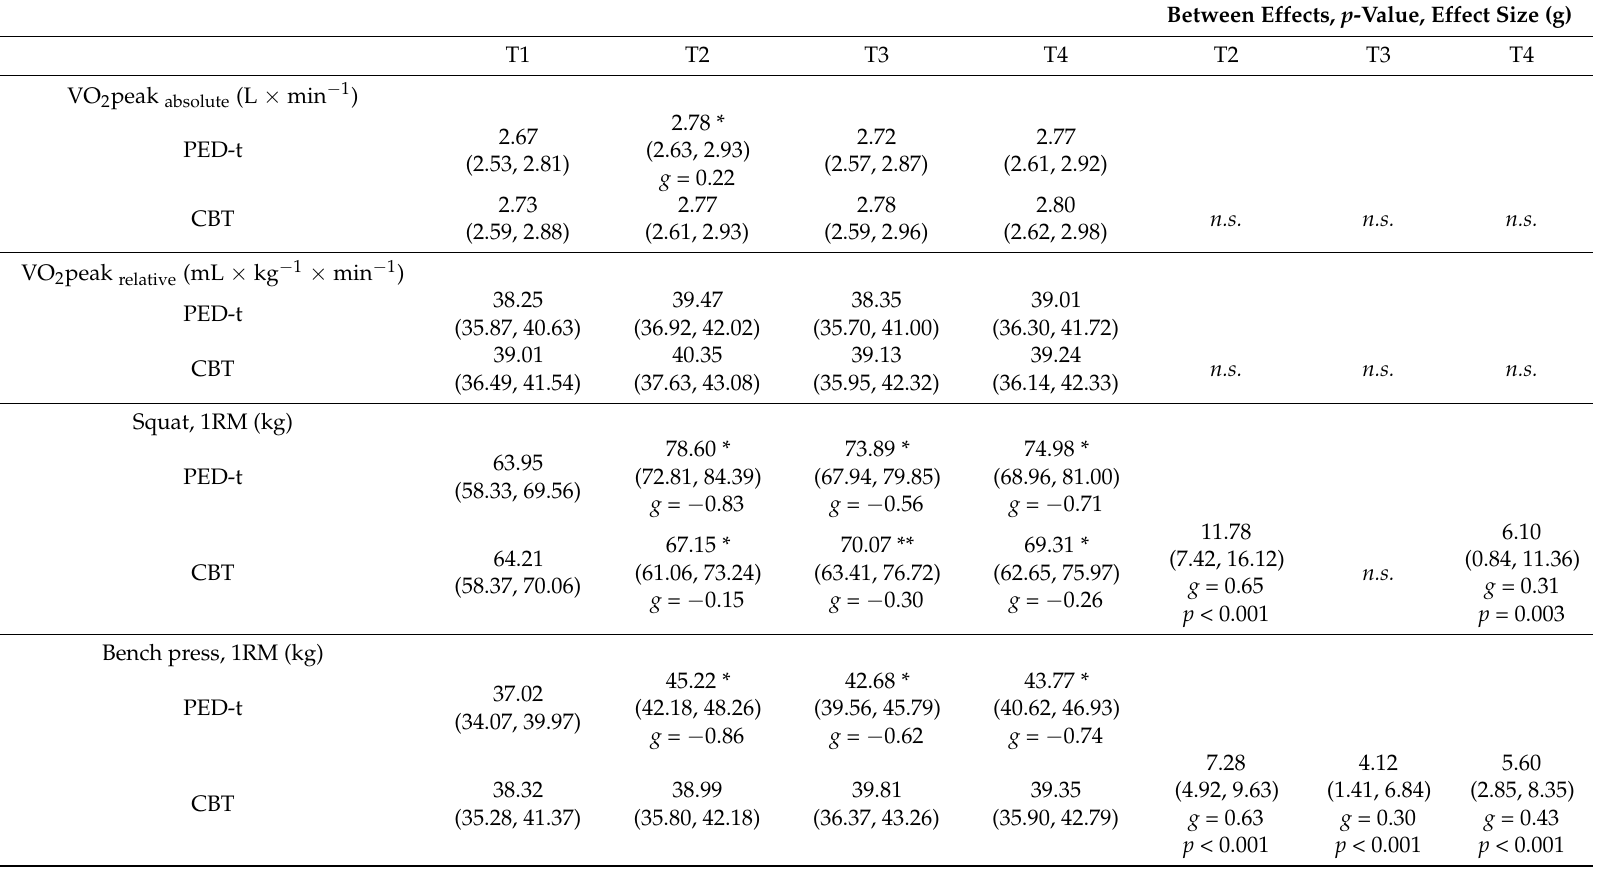
Table 3. VO 2 peak absolute, VO 2 peak relative to BW, and maximal strength (1RM) in squats, bench press, and seated row at T1–T4. Results are estimated means (99% CI), and significant within-group changes are marked with